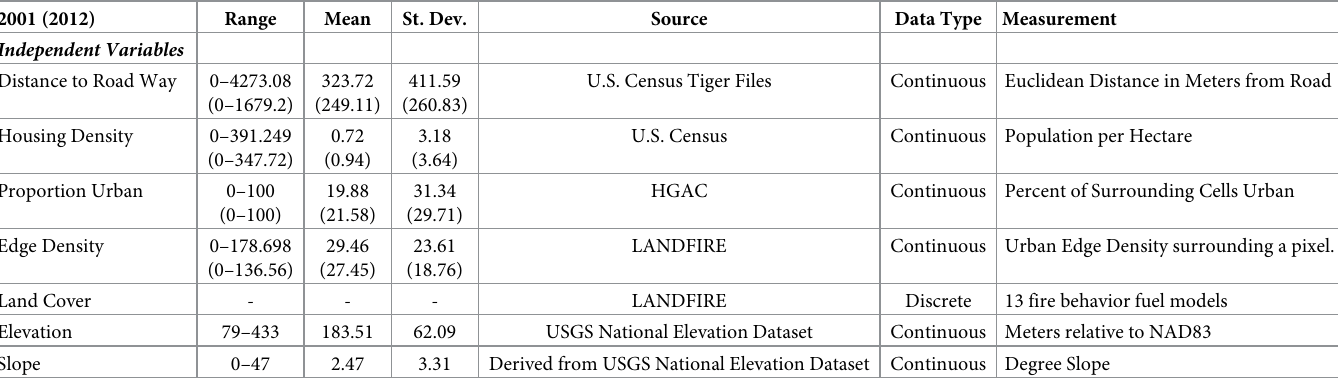
Table 2. Independent variables and descriptive statistics for the study